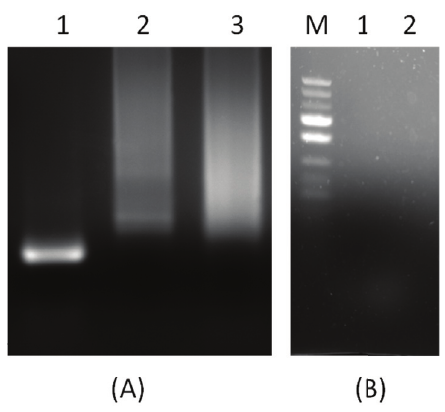
Figure 4. ( A ): A control reaction showing that PCR products were obtained when both primers were added as per scheme in Figure 2. In Figure 4 (A), Lane 1 shows 120 bp PCR products synthesized by PD-PCR, while in Lanes 2 and 3, only single primers were added and as expected no PCR product was synthesized. Figure 4(B) shows a negative control reaction of conventional PCR and